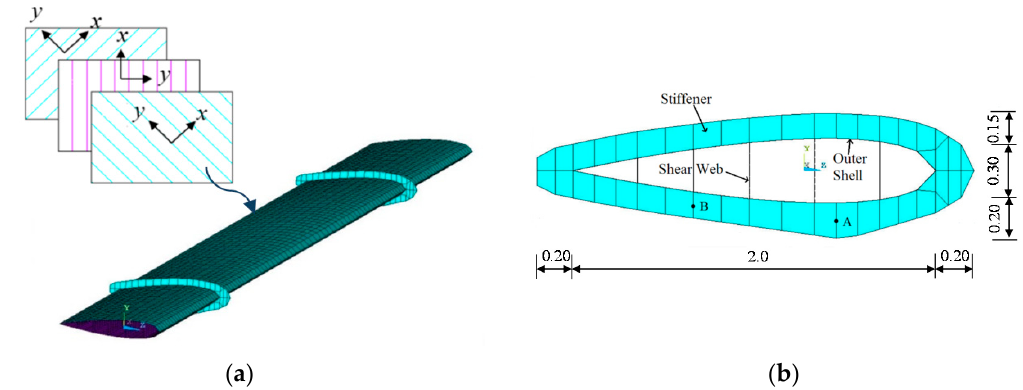
Figure 2. Finite element (FE) model of the blade: ( a ) Top view; ( b ) Side view (unit: m).